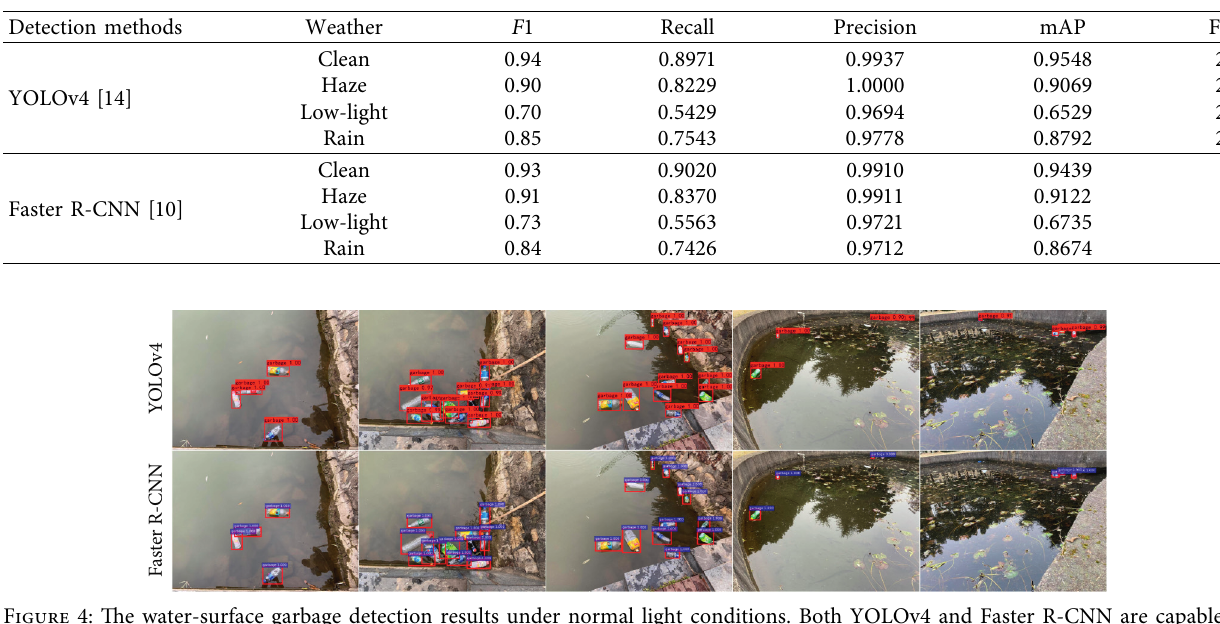
Table 1: The influences of different weather conditions on water-surface target detection. Several objective criteria (i.e., F 1, Recall, Precision, mAP, and FPS) are simultaneously adopted to quantitatively evaluate the detection results.